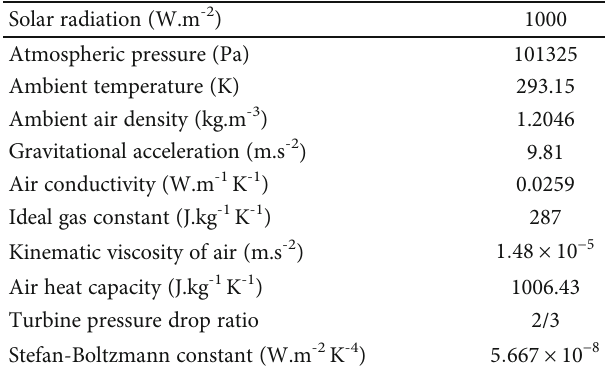
Table 3: CFD parameters and climatic characteristics